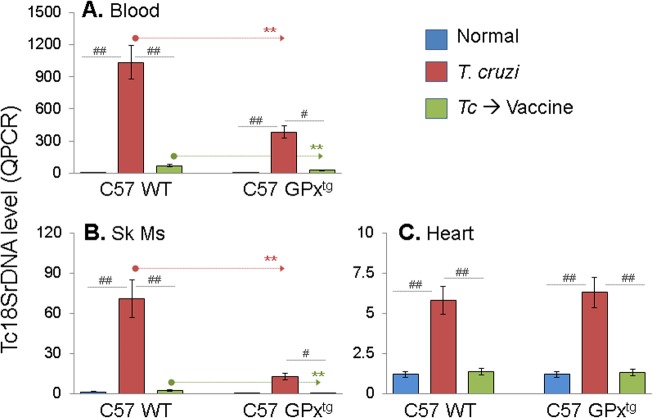
Control of T. cruzi persistence by a therapeutic vaccine in GPx-transgenic and wild-type mice.Glutathione peroxidase 1 over-expressing (GPx-transgenic, GPxtg) mice and wild-type (WT) littermates were infected with T. cruzi trypomastigotes (10,000 parasites/mouse), and immunized with a two-component DNA-prime/protein boost (D/P) vaccine (1st dose: TcG2- and TcG4-encoding plasmids + IL-12- and GMCSF-expression plasmids at 45 days post-infection (pi); and 2nd dose: recombinant TcG2 and TcG4 proteins at 66 days pi), as detailed in Materials and Methods. Mice were harvested at 150 days pi corresponding to the chronic disease phase. Total DNA isolated from blood (A), skeletal muscle (B) and heart (C) of the infected/vaccinated and infected/non-vaccinated mice were subjected to quantitative real time PCR amplification for Tc18SrDNA sequence. Bar graphs show the Tc18SrDNA level normalized to murine GAPDH gene. In all figures, data are expressed as mean ± SD, and significance is presented as #,*
P < 0.05 and ##,**
P < 0.01 (* wild-type versus GPxtg; # wild-type versus infected, or infected versus infected/vaccinated).